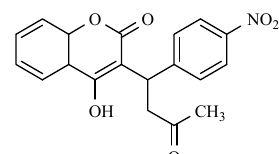
Figure 2. The chemical structure of acenocoumarol.